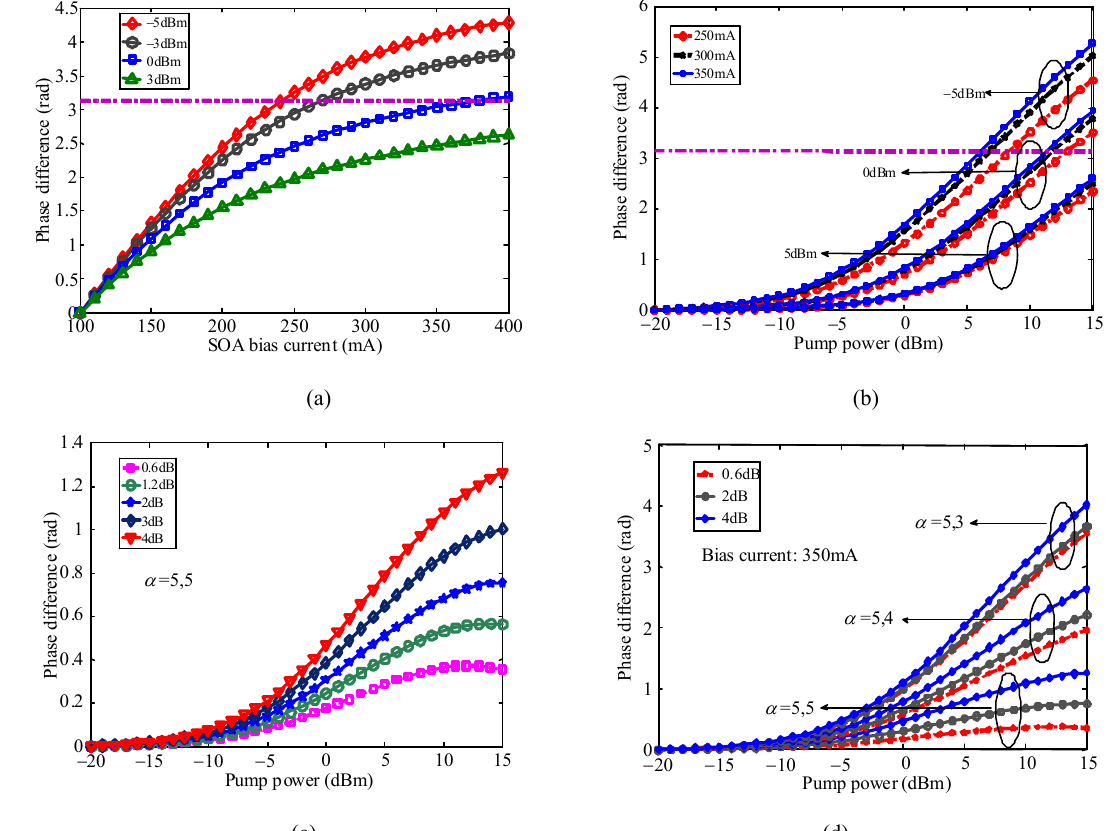
Fig. 3 Curves of phase difference: (a) with bias current and probe power, (b) with pump power, probe power, and bias current, (c) with PDG and pump power, and (d) with PDG, LEF, and pump power.